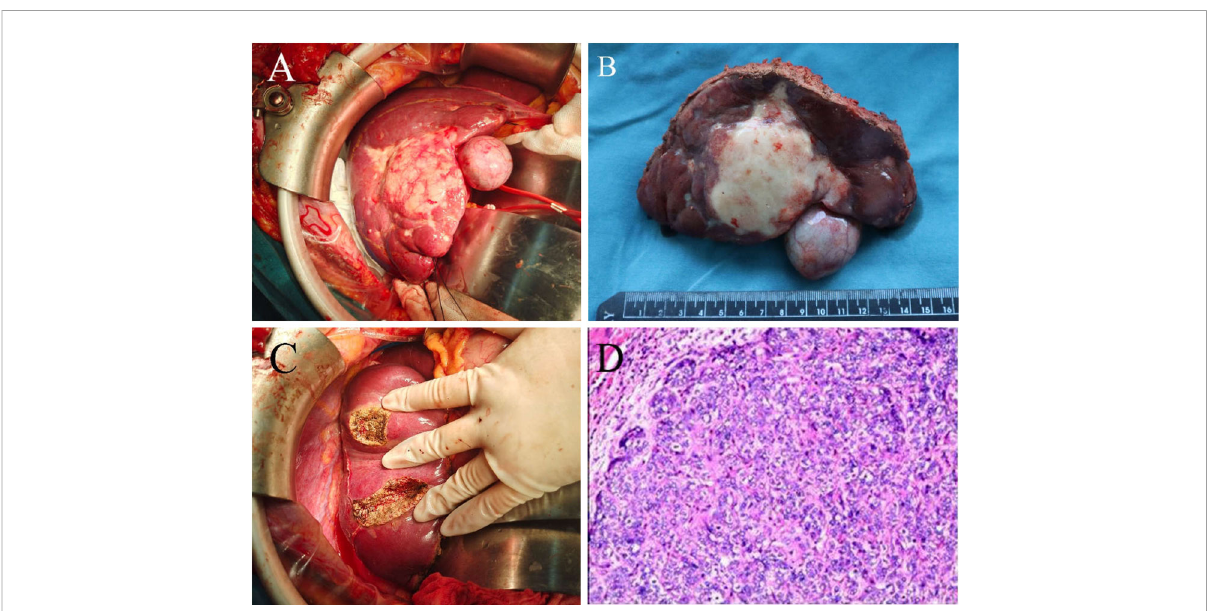
FIGURE 3 Intraoperative gross pathological specimen and H&E staining of resected specimen of a patient with advanced ICC who underwent radical liver resection. (A) and (B) A hard mass with a size of 7.5 x 5.3 cm was observed on the segment 4b, 5,6 of the liver, which was closely adjacent to the gallbladder. There were multiple satellite nodules surrounding the tumor. (C) Two lesions in segments 7 and segment 8 were completely resected. (D) H&E staining of resected tumor samples revealed predominately necrosis (>95%), hyaline change and cholesterol